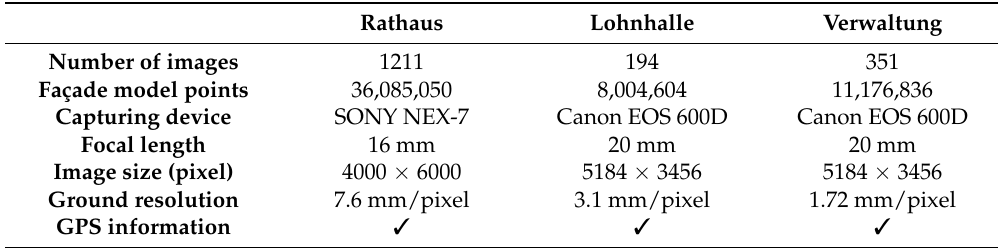
Table 1. Details of ground image